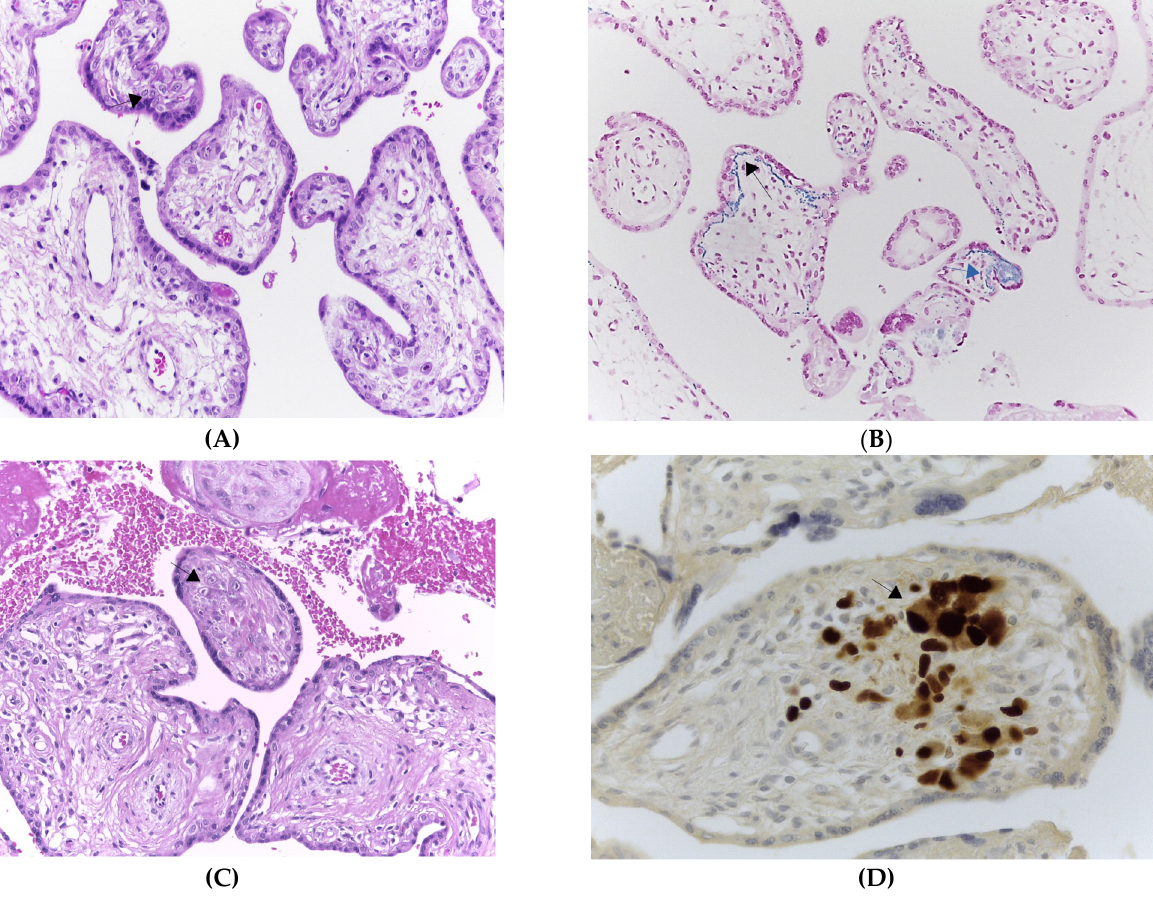
Figure 3. Placenta histological examination with arrows displaying: ( A ) Increased stromal fibrosis, decreased number of capillaries and presence of lymphocytes and plasma-cells (H&E stain, 200× magnification). ( B ) Hemosiderin depositions on trophoblastic basal membrane (Perls staining positive, 200× magnification). ( C ) Cytomegalic stromal cells with eosinophil intranuclear inclusion bodies (H&E stain, 200× and 400× magnification). ( D ) Immunostaining for CMV immediate early (IE1/2) antigens displaying a strong and diffuse nuclear positivity (400× magnification).